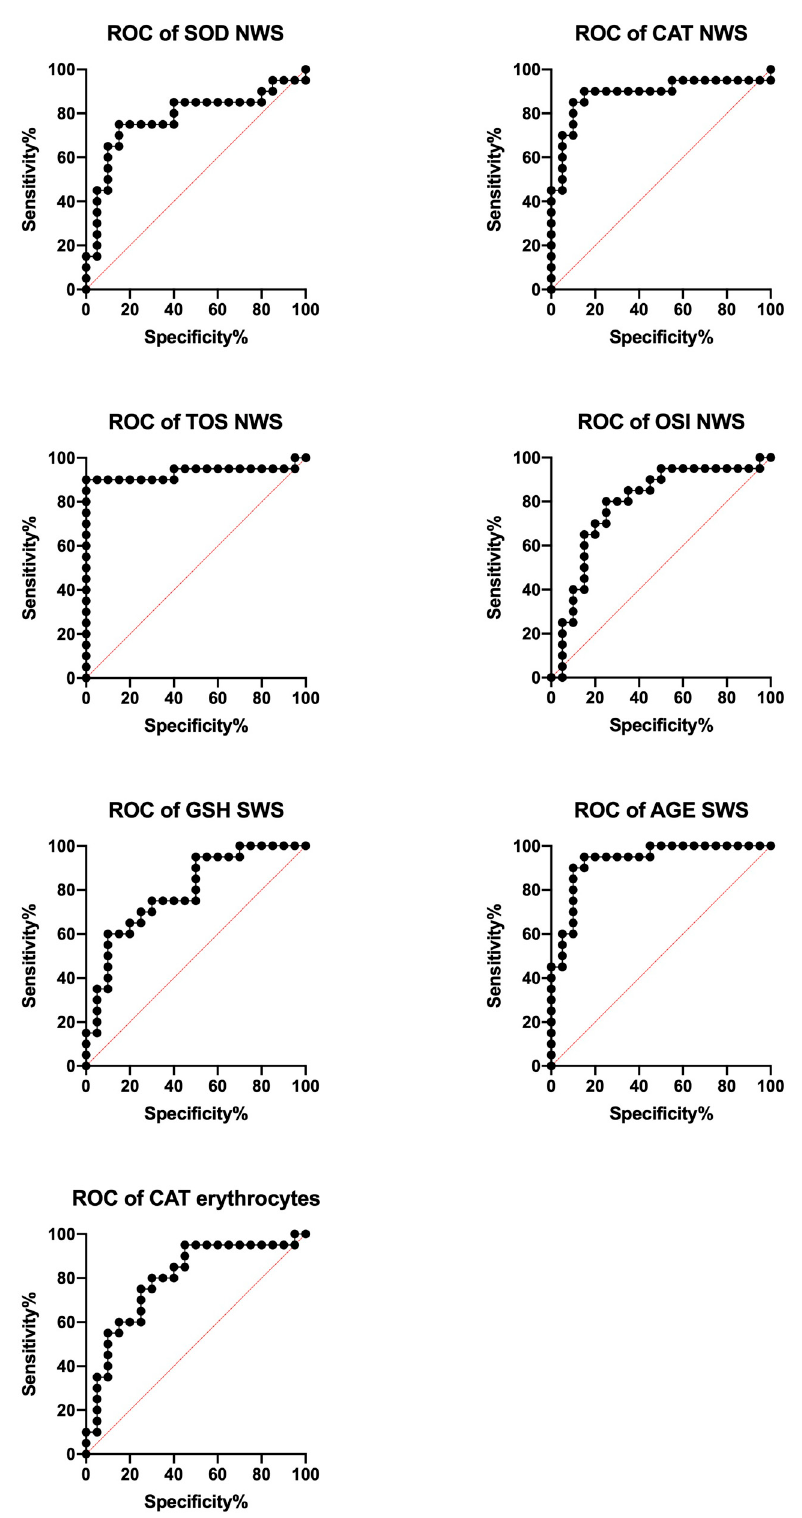
Figure 6. Area under the curve (AUC) of selected redox biomarkers in overweight and obese children. AGE- advanced glycation end products, CAT- catalase, GSH- reduced glutathione, NWS- non-stimulated whole saliva, OSI- oxidative stress index, SOD- superoxide dismutase, SWS- stimulated whole saliva, TOS- total oxidative status, UA- uric acid, 4-HNE- 4-hydroxynoneal protein